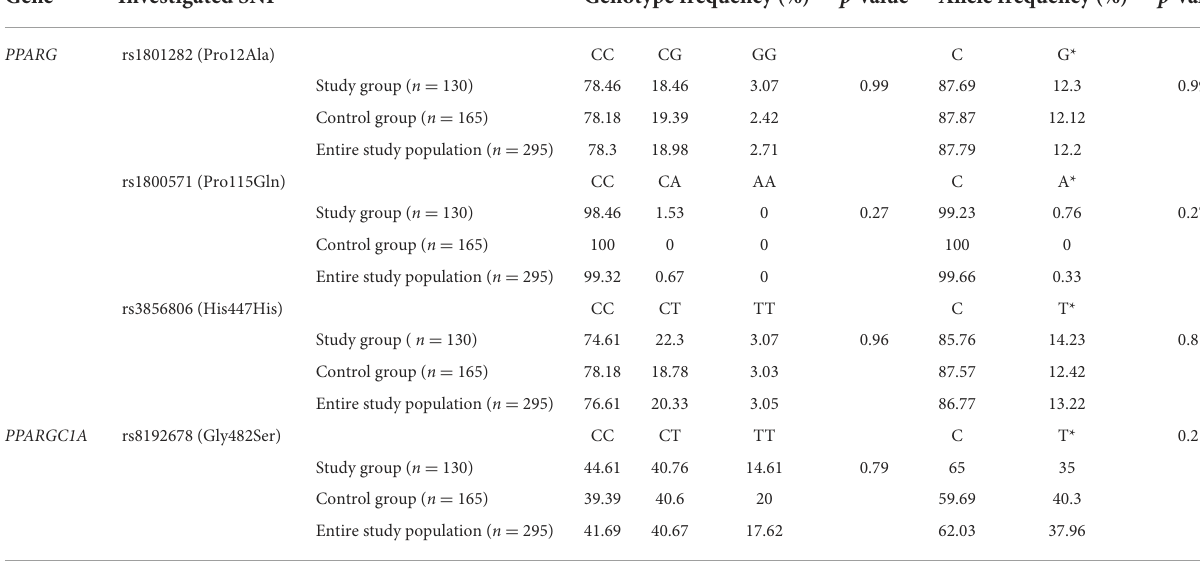
TABLE 2 Comparison of the genotype and allele frequencies of investigated SNPs within the entire study cohort, between the study (overweight/obese) group and control group. Gene Investigated SNP Genotype frequency (%) p- value Allele frequency (%) p -value